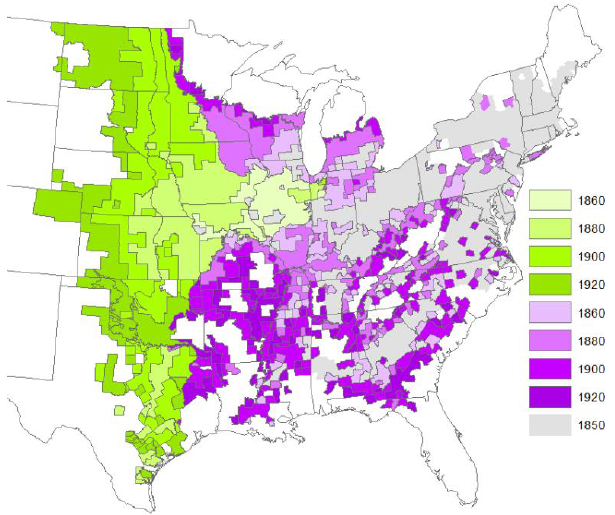
Figure 2. Decade where area in agriculture reached ≥ 25% for four grassland landscapes (green) and four forest landscapes (purple). Gray designates where area in agriculture was ≥ 25% by 1850, at the beginning of the agricultural surveys.